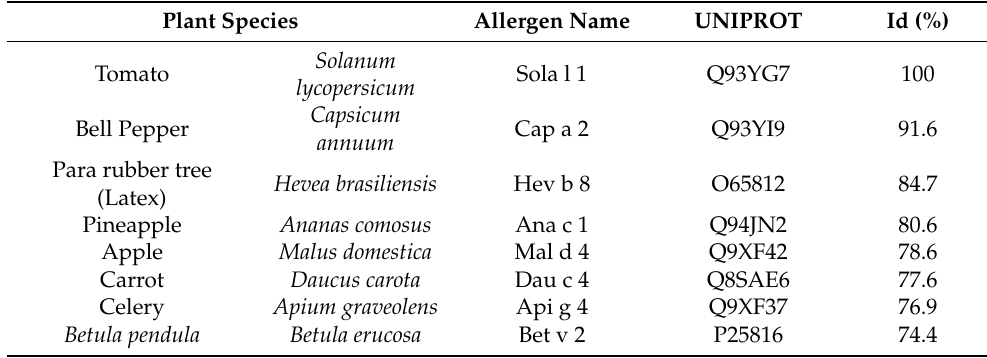
Table 4. Chosen allergens belonging to the Profilin Family *.